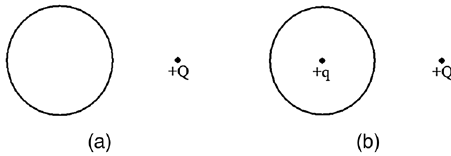
FIG. 4. Diagrams provided for Q13 (a) and Q14 (b) on the